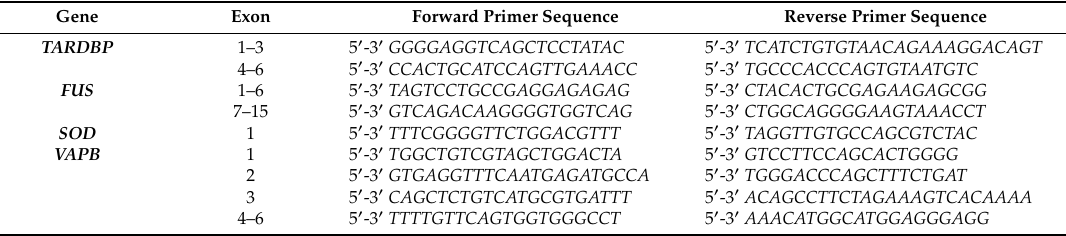
Table 2. Primer pairs used for next-generation sequencing (NGS)